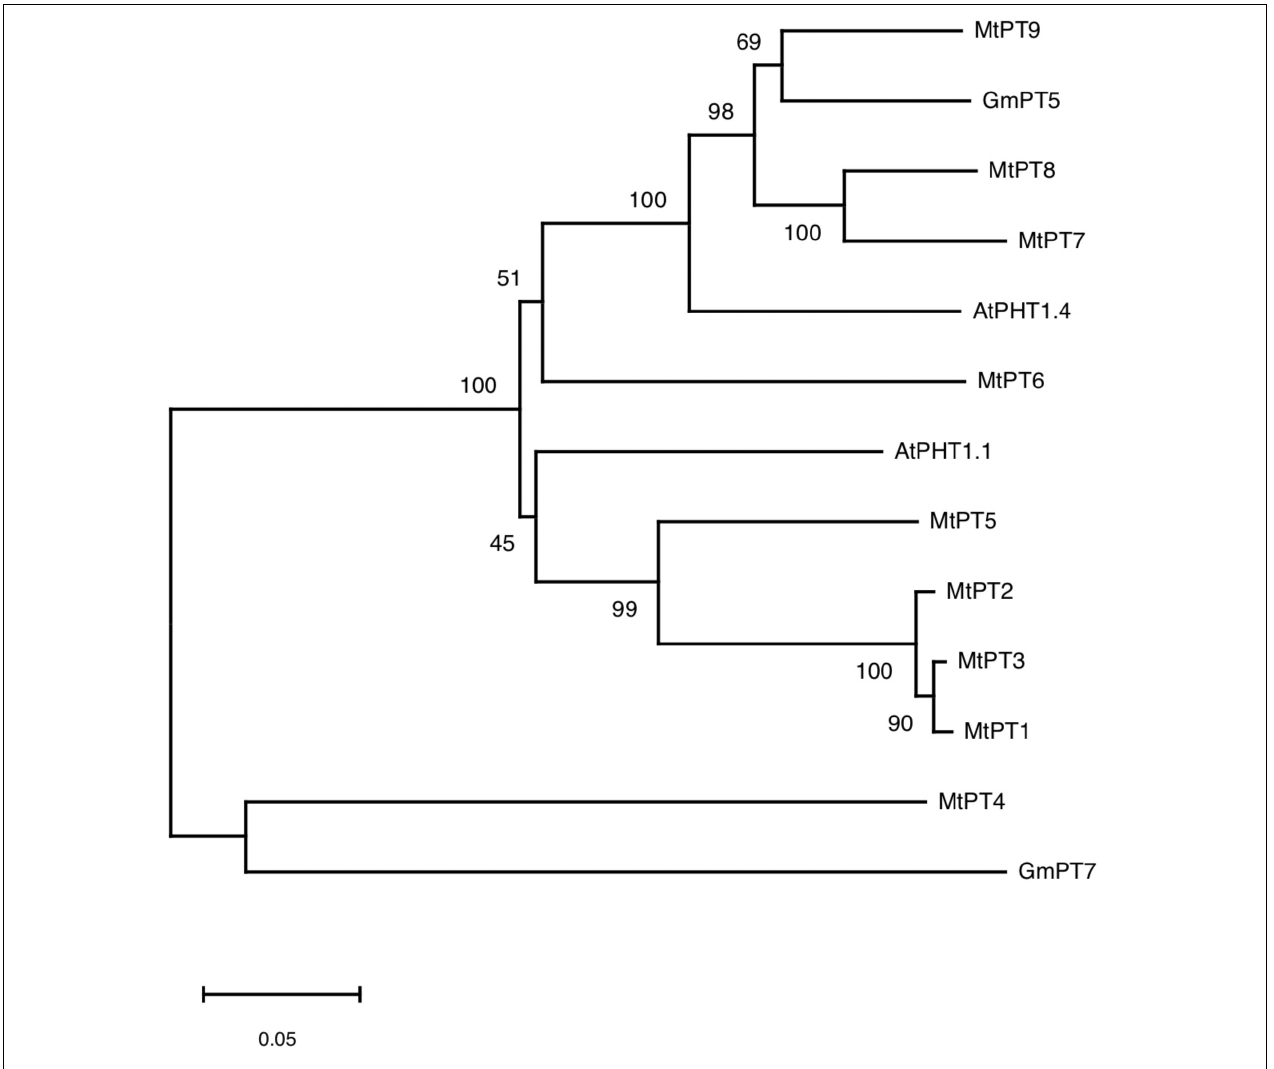
FIGURE 1 | Phylogram of phosphate transporters of Medicago truncatula , Arabidopsis , and soybean.